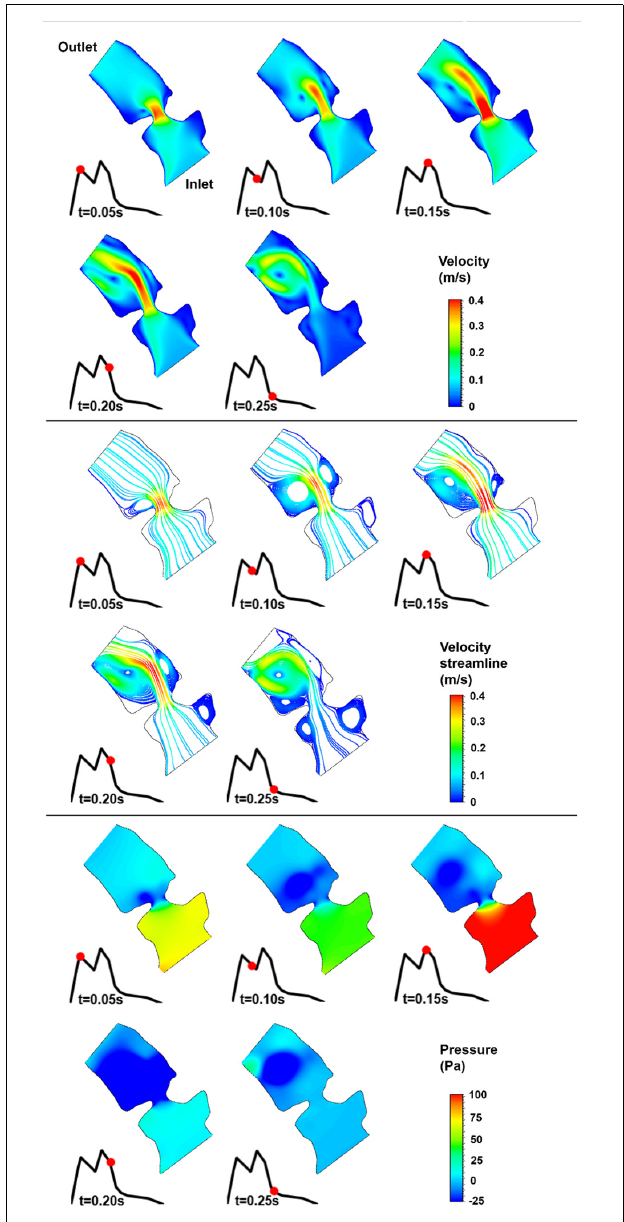
FIGURE 10 | Velocity magnitude, velocity streamline, and pressure contours for the control 3 heart at week 26. The instant in the cardiac cycle is shown near the